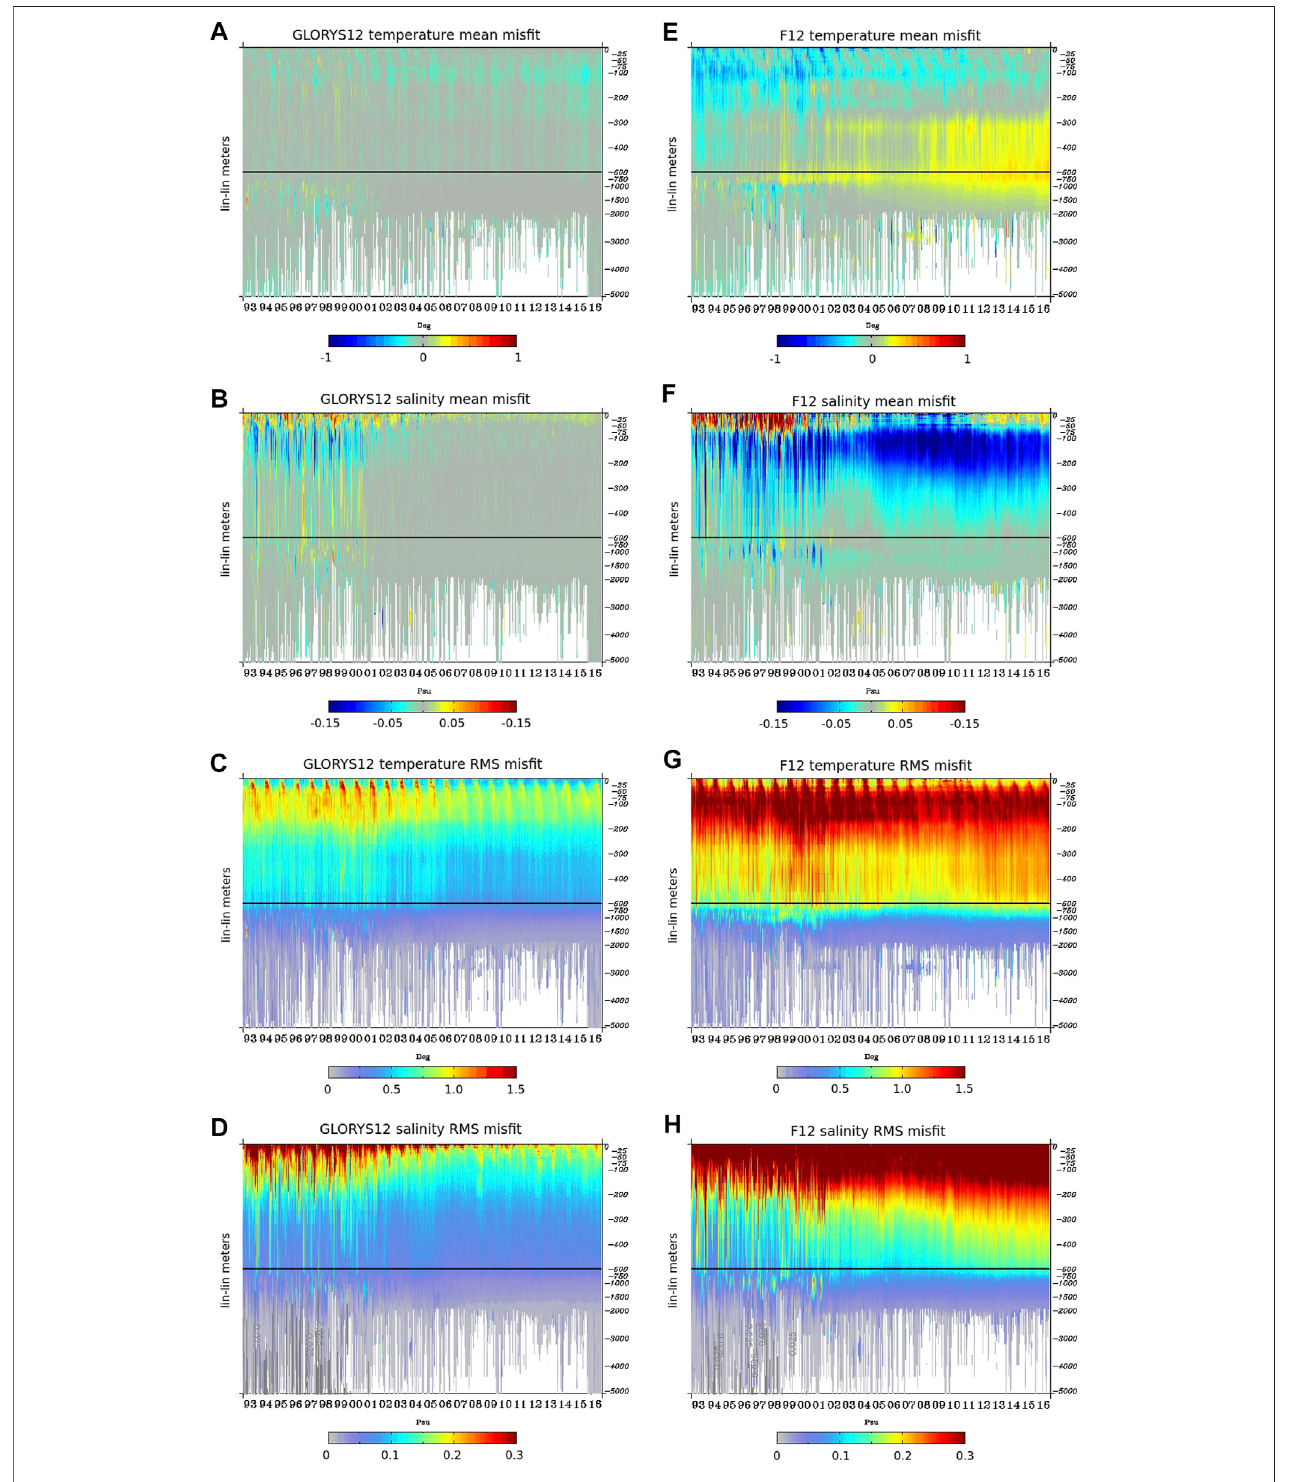
FIGURE 1 | Assimilation diagnostics with respect to the vertical temperature and salinity pro fi les over the 1993 – 2016 period. Mean mis fi ts (observation minus background model fi rst trajectory) for temperature (A,E) and for salinity (B,F) and RMS mis fi ts for temperature (C,G) and for salinity (D,H) . Left panels (respectively right panels) concern GLORYS12 (respectivelyF12). These scoresare averaged overall seven days ofthedata assimilationwindow, with amean lead time equal to3.5 days. Units are ° C for temperature and psu for salinity.